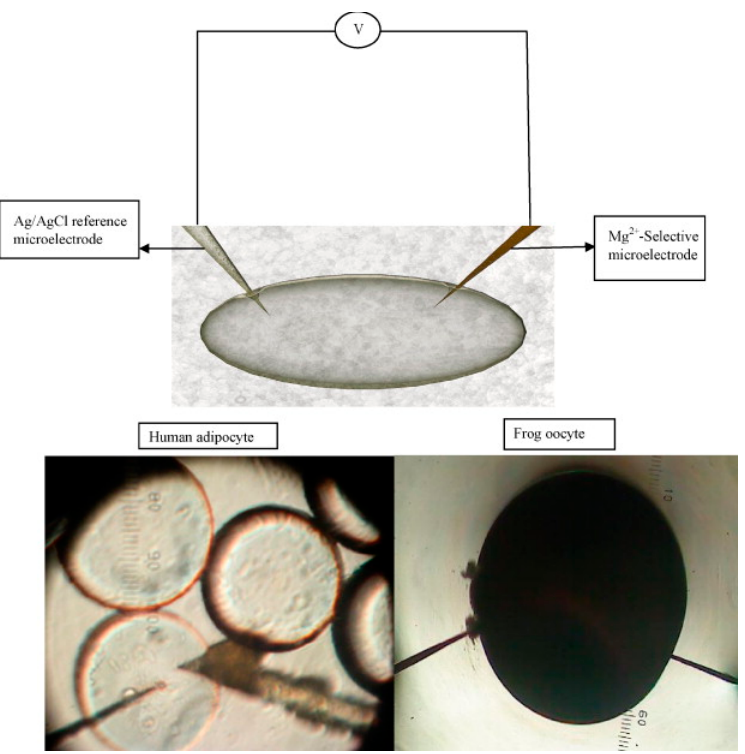
Figure 9. Schematic image of the two electrodes measurement setup. Microscopic images of human cells (adipocytes) and a single frog cell (oocyte) [52].